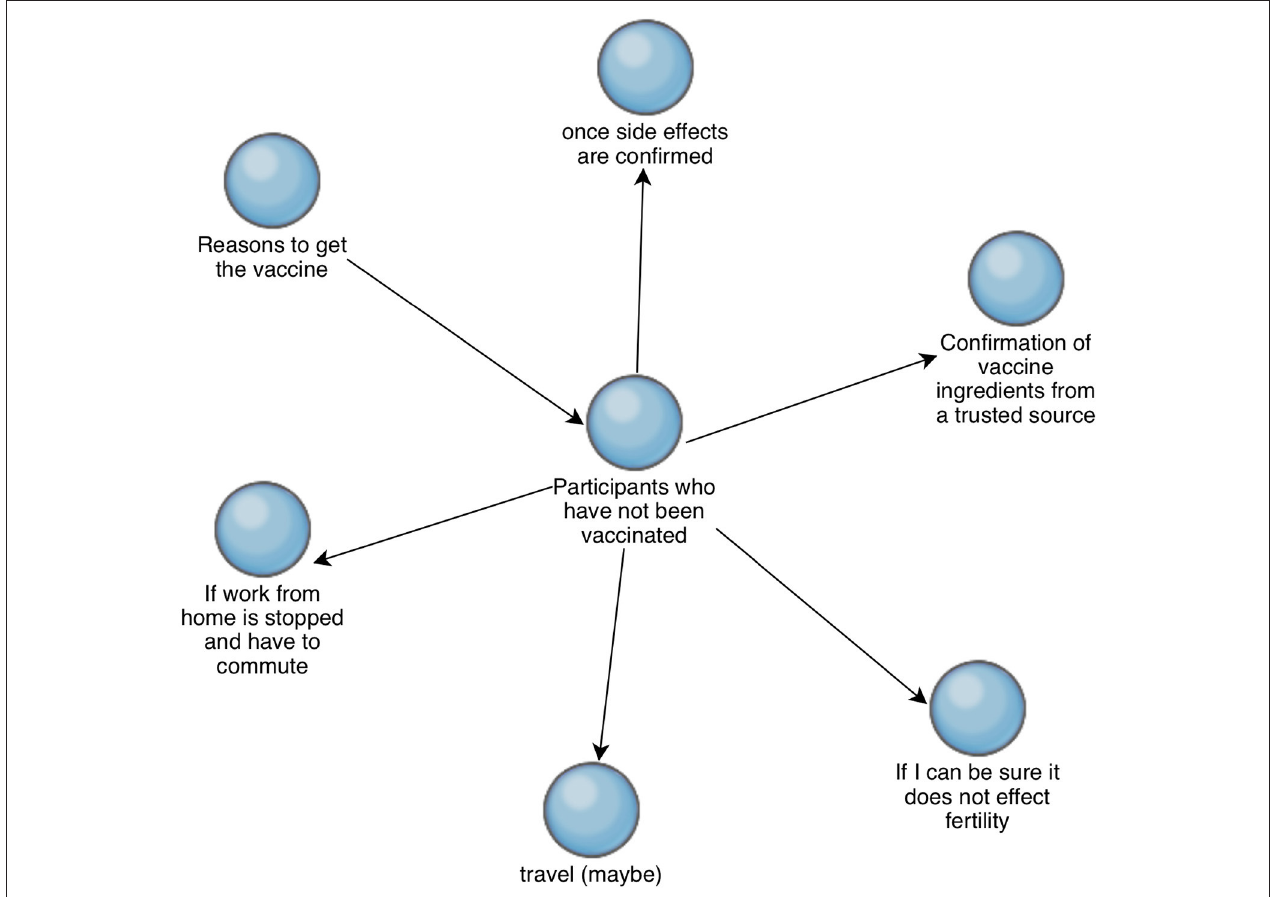
FIGURE 4 | Health Belief Model from Abraham and Sheeran